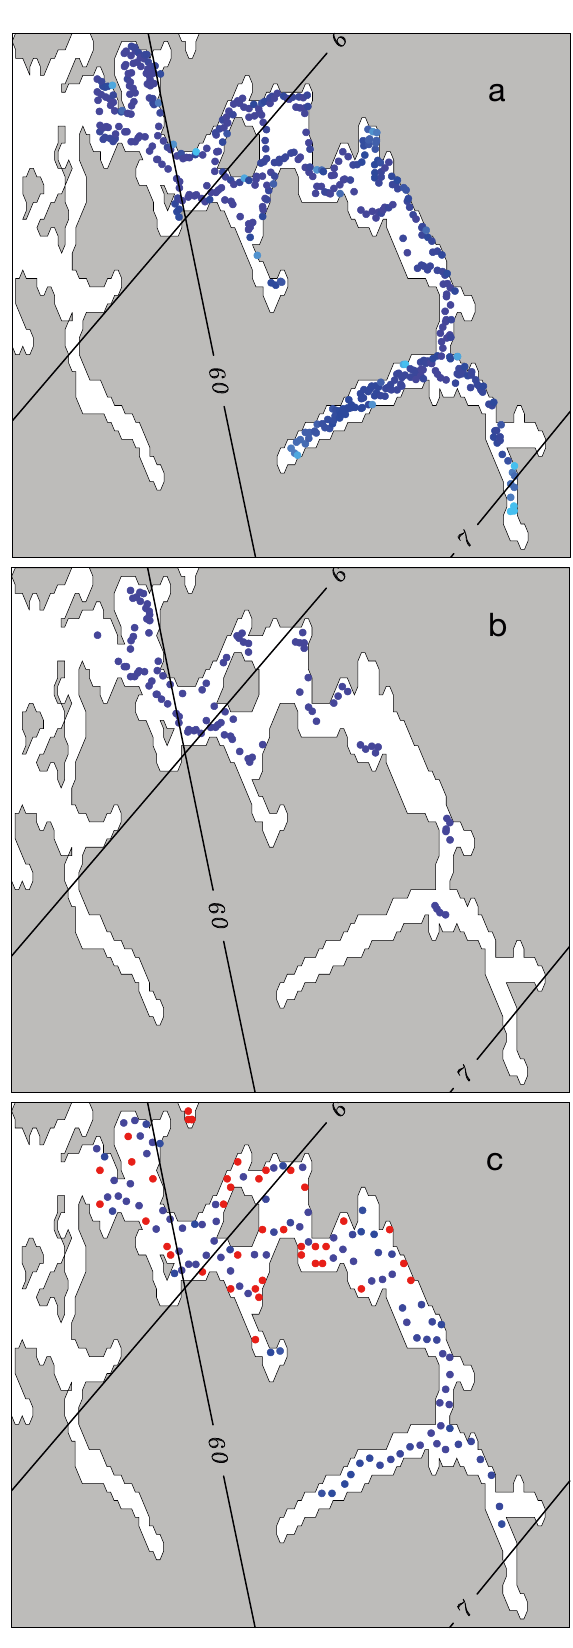
Fig. 4. Site selection. (a) All possible sites for mussel farms, (b) the 100 best sites in terms of production potential, and (c) the 100 best sites meeting the constraint of a minimum 1.6 km distance between farms. Colors indicate structural vol- ume (V , as a proxy of growth) with darkest blue the highest. Red dots show existing sites of fish